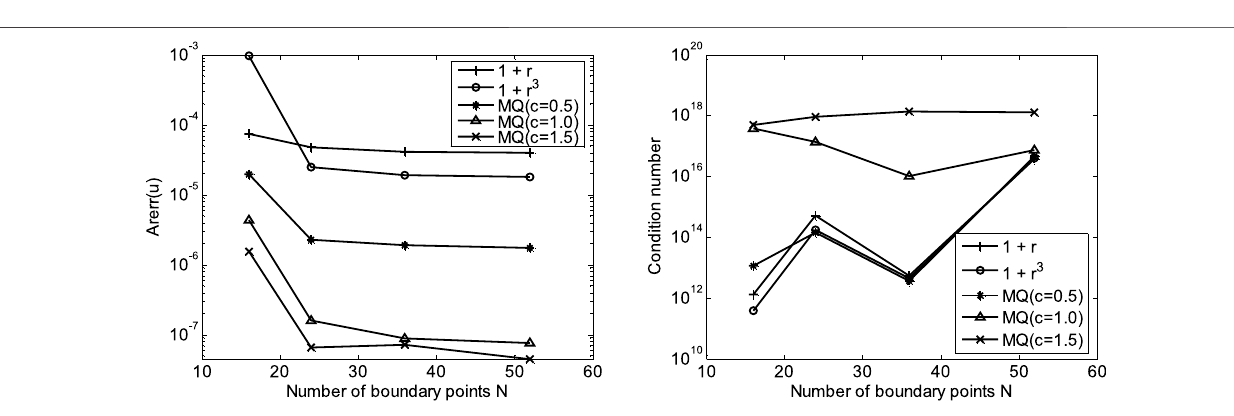
FIGURE 3 | Convergence curves of average relative error and condition number with M = 64 by using different interpolating RBFs.